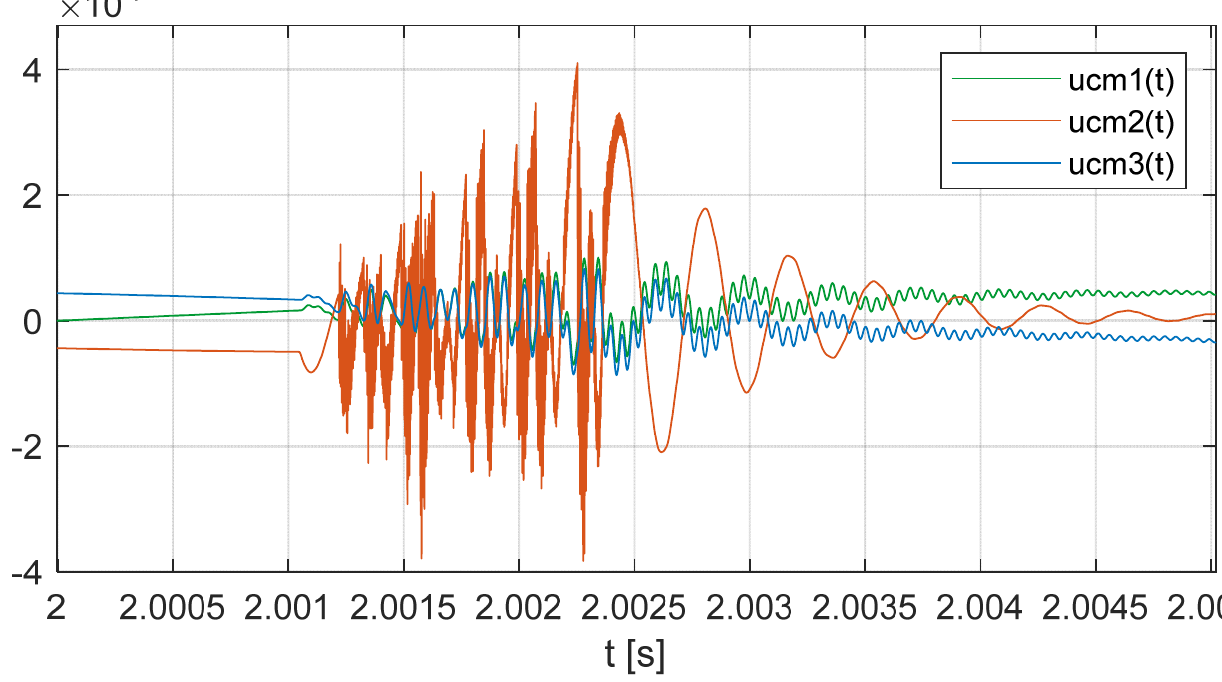
(𝑡) (Clark transformation). Source: own calcula- (cid:3004) (cid:3262)